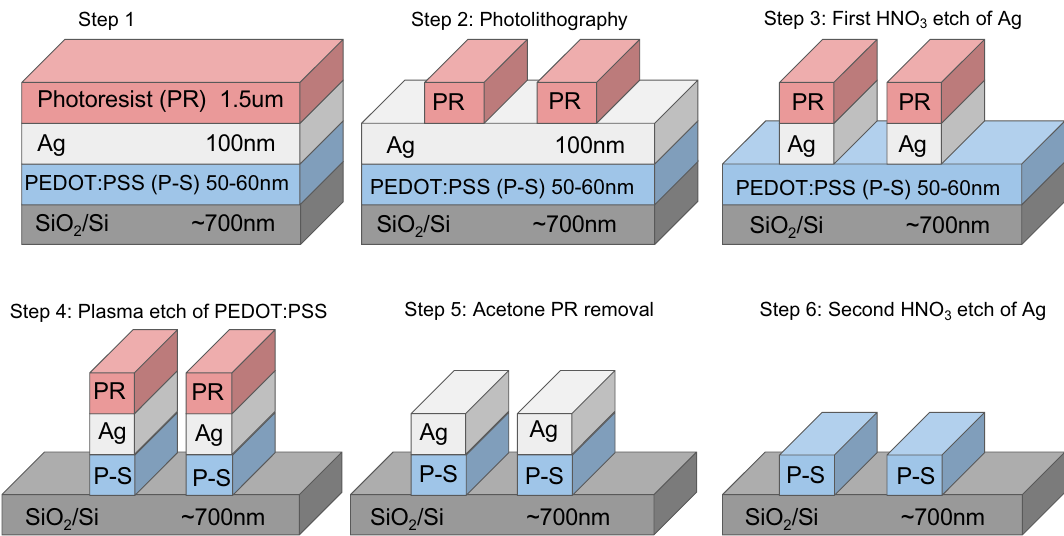
Figure 1. Photolithography process flow to pattern PEDOT:PSS films on oxidized Si wafers and on Mylar flexible substrates using Ag as sacrificial layer to protect PEDOT:PSS from damage during the photolithography exposure and photoresist ashing.